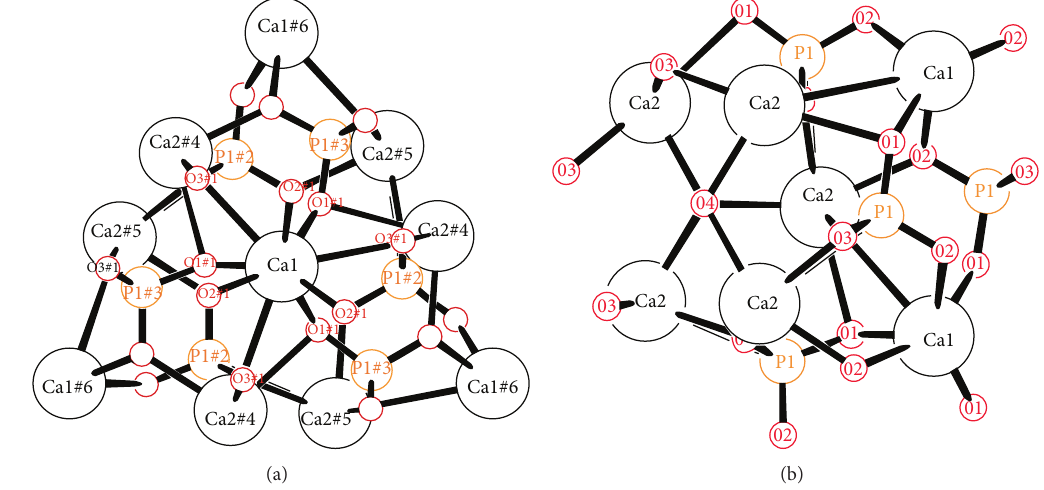
Figure 1: Projection drawings down [001] of (a) Ca(I) site and (b) the Ca(II) site in CaHAp.